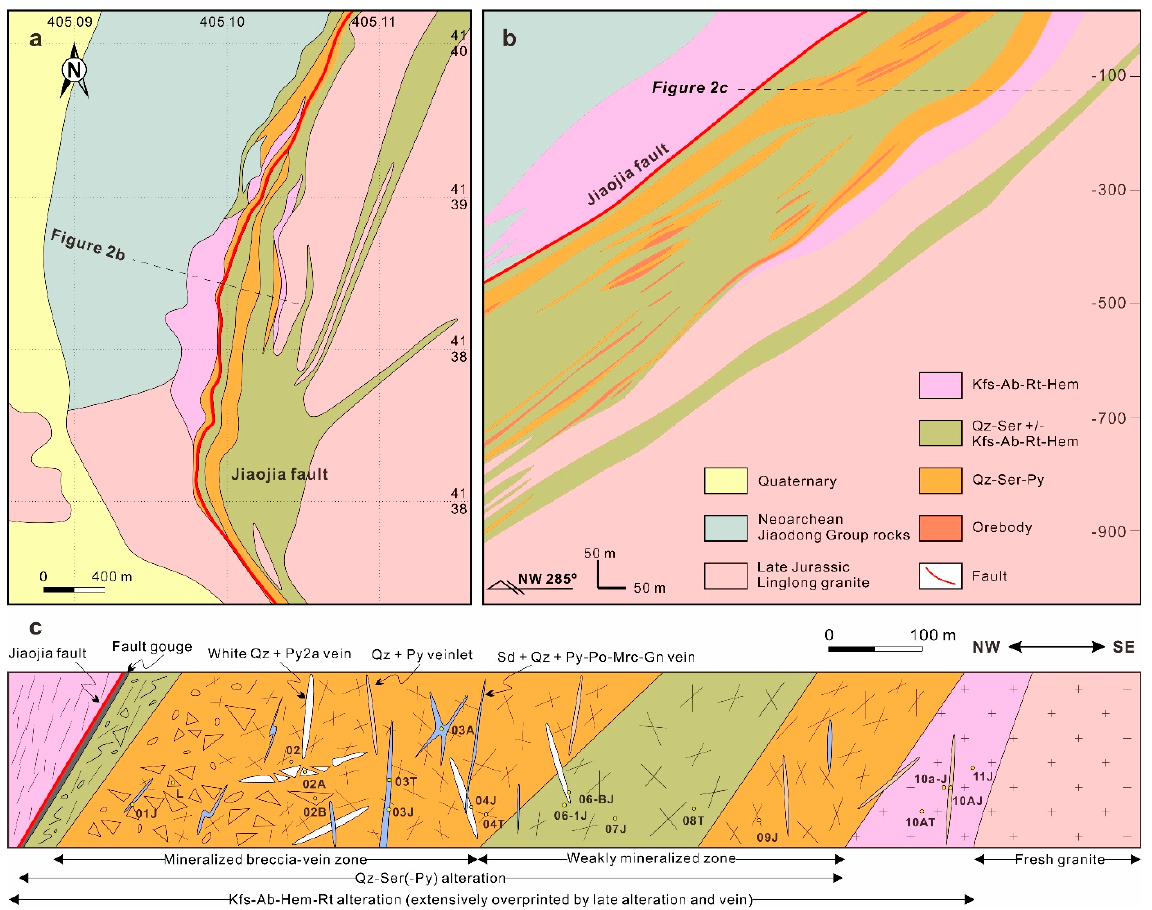
Figure 2. ( a,b ) Geological map and representative cross-section (line 288) of the Sizhuang gold deposit (Modified from unpublished report of No. 6 Exploration institute of geology and mineral resources of Shandong Province). ( c ) Mineralization and alteration section involved in this study showing sample locations and relationships among fault, breccia, vein, and alteration. The number-letters in 2c stand for sample numbers. Ab: albite; Gn: galena; Hem: hematite; Kfs: K-feldspar;